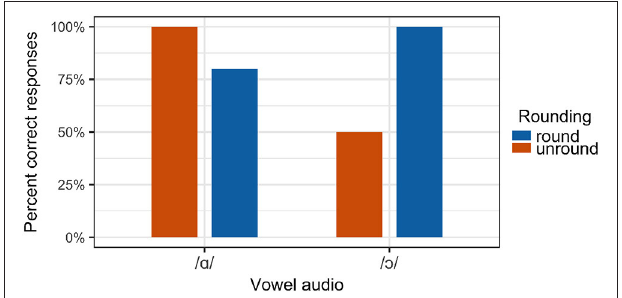
FIGURE 12 | Perception results for Participant 2. FIGURE 13 | Perception results for Participant